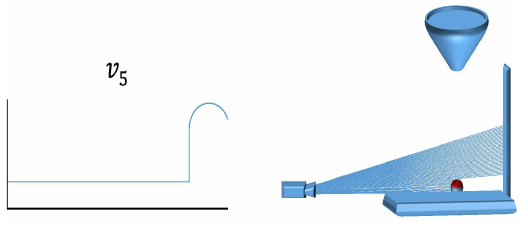
Time t 5 . The marble oscillate on the board downwards. Figure 10. Time step illustration (for t 0 , . . . , t 5 ) of the system state ( right ) and the corresponding depth vector v depending on the laser beam blocking ( left ).